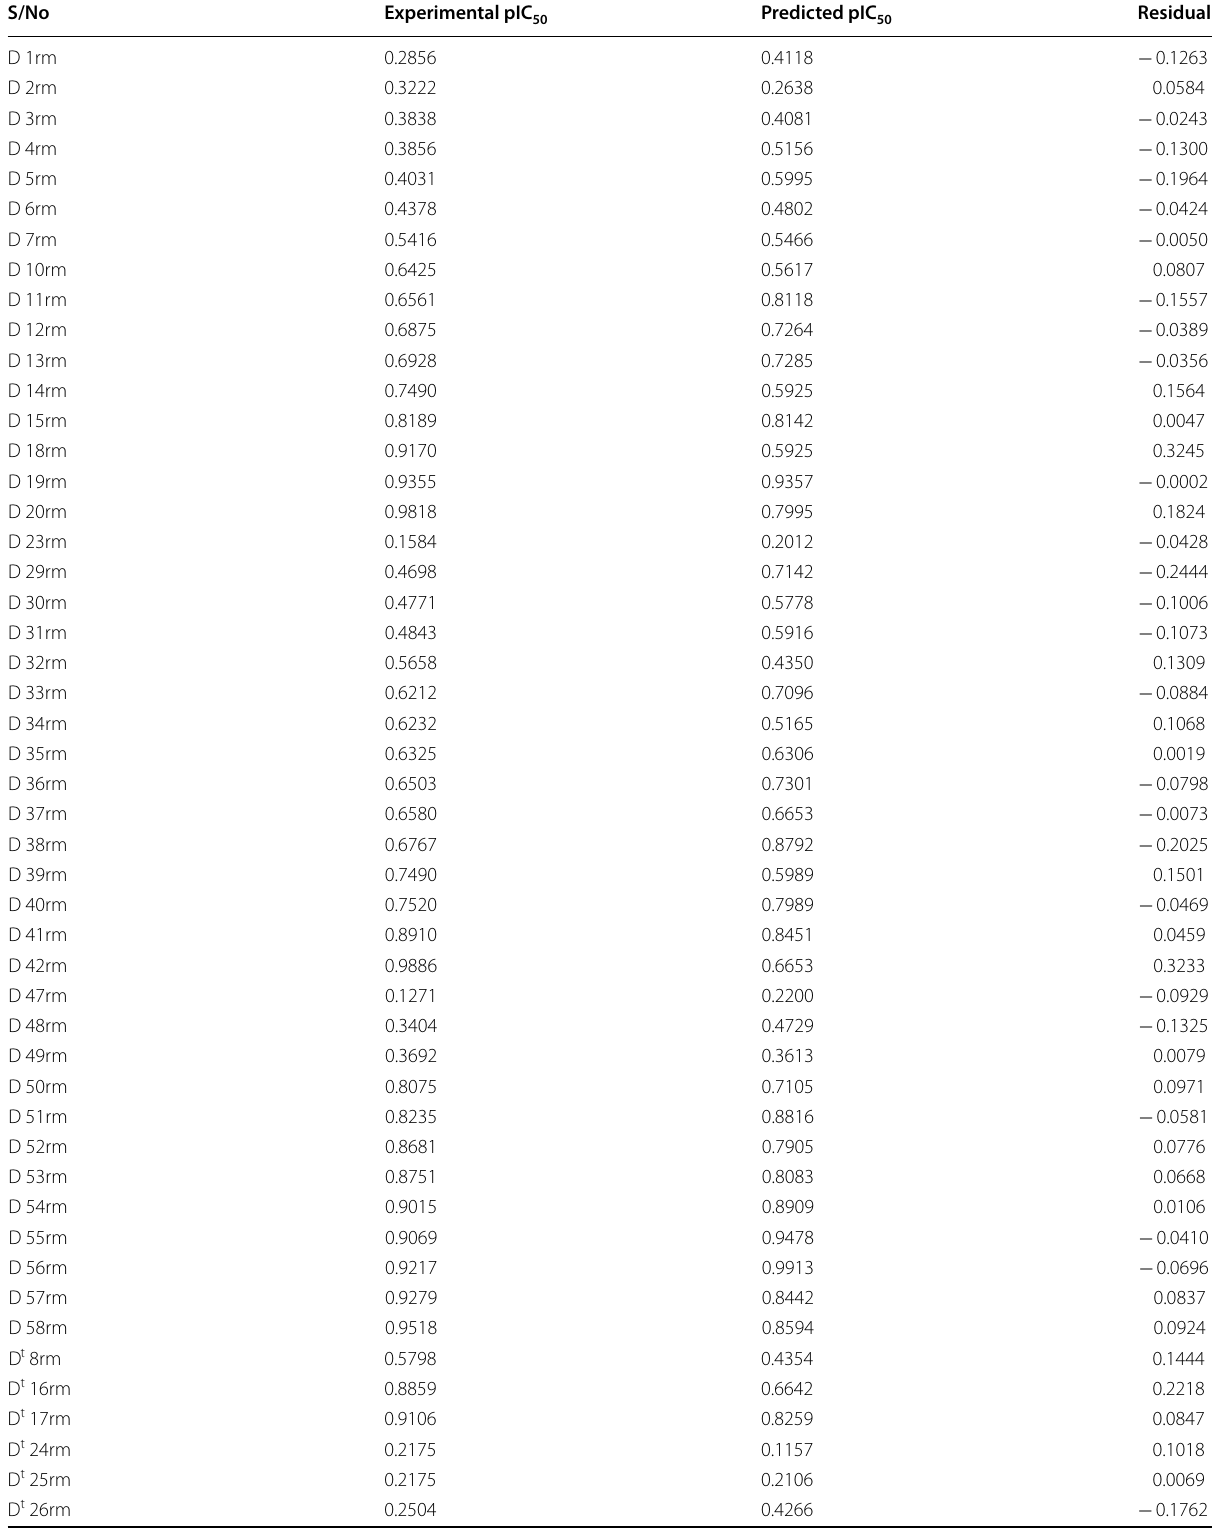
Table 5 Comparison of experimental predicted and residual of the data set